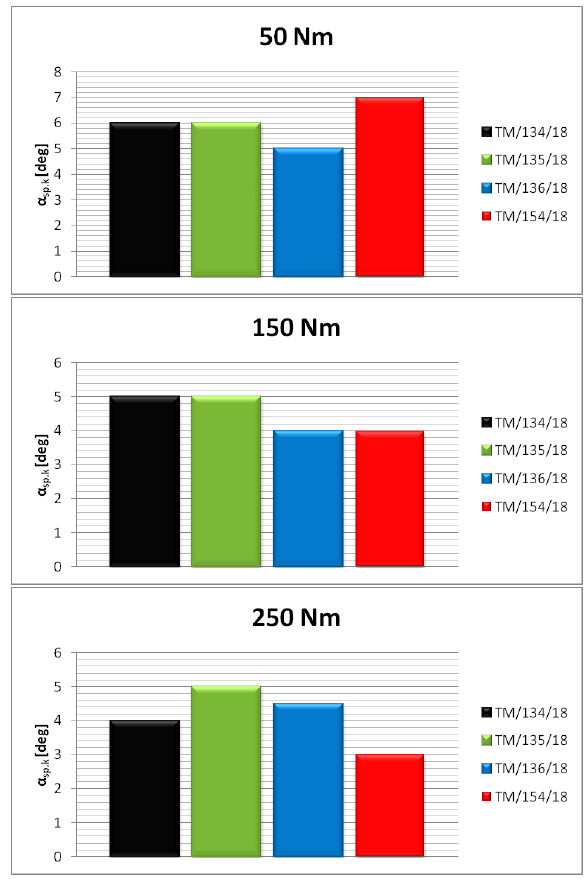
Fig. 10. Duration of kinetic combustion (  sp.k ) in the cylinder at selected duty points of the engine for the four tested